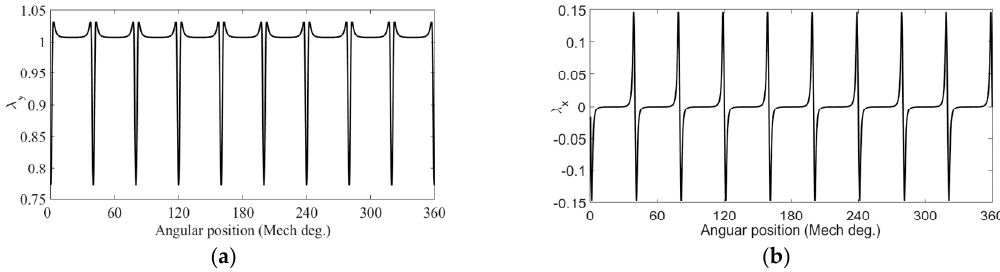
Figure 8. Complex relative permeance without eccentricity in the middle of air gap. ( a ) Axial component; and ( b ) Circumferential component.